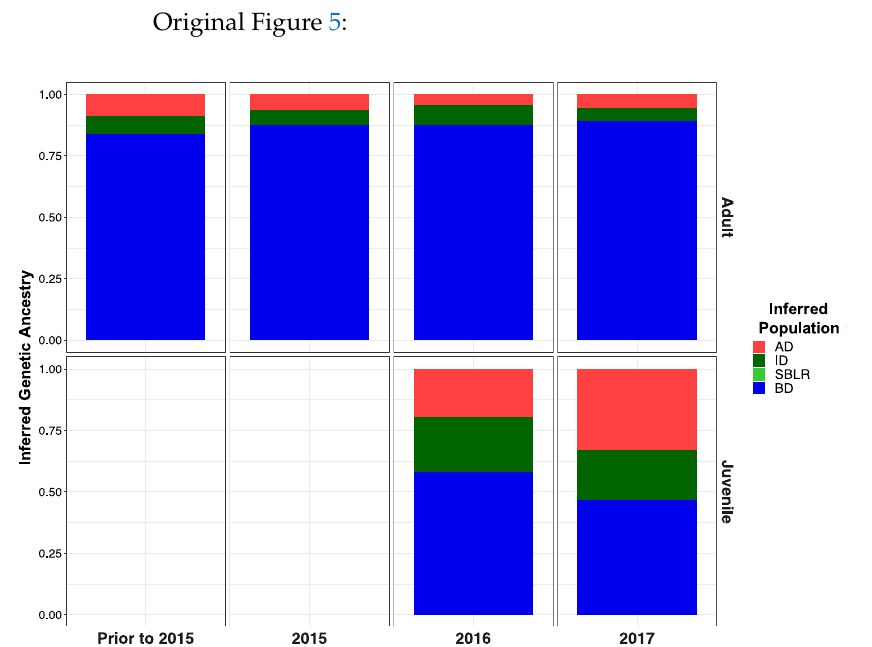
Genes 2022 , 13 , x FOR PEER REVIEW